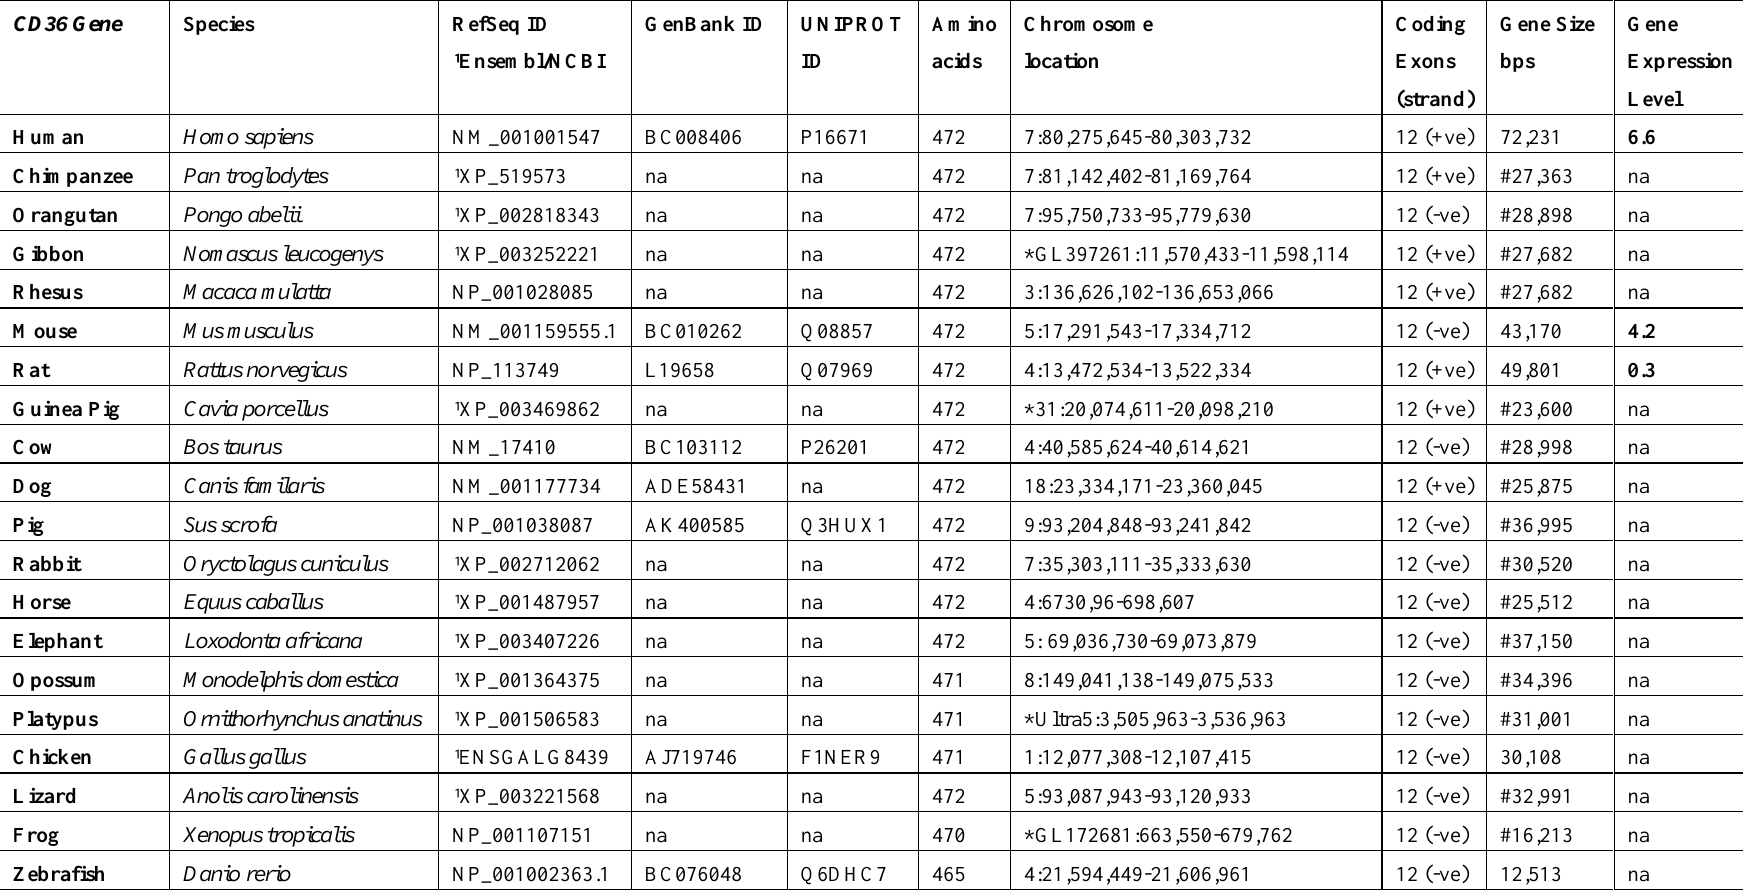
Table 1. CD36 , SCARB1 and SCARB2 genes and proteins. RefSeq: the reference amino acid sequence; ¹predicted Ensembl amino acid sequence; na-not available; GenBank IDs are derived from NCBI http://www.ncbi.nlm.nih.gov/genbank/; Ensembl ID was derived from Ensembl genome database http://www.ensembl.org; * designates scaffold; Un refers to unknown chromosome; UNIPROT refers to UniprotKB/Swiss-Prot IDs for individual CD36-like proteins (see http://kr.expasy.org); Un-refers to unknown chromosome; bps refers to base pairs of nucleotide sequences; the number of coding exons are listed; gene expression levels are in bold